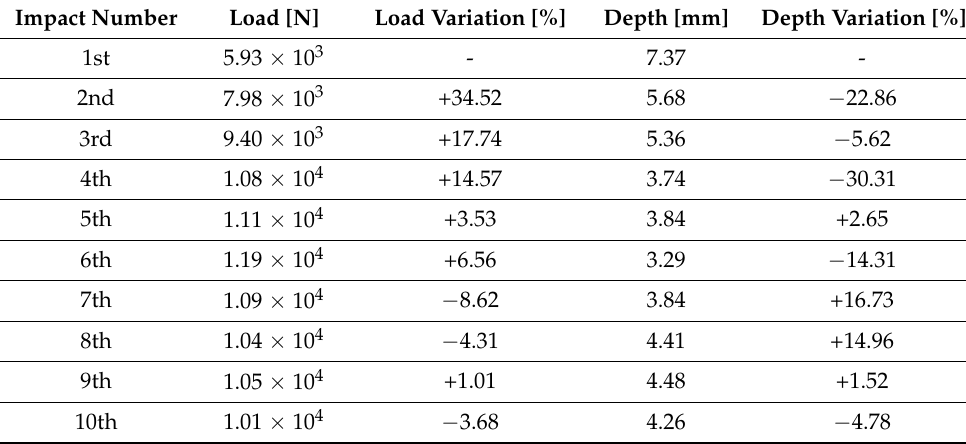
Table 3. Load and depth percentage variation after the repeated impact